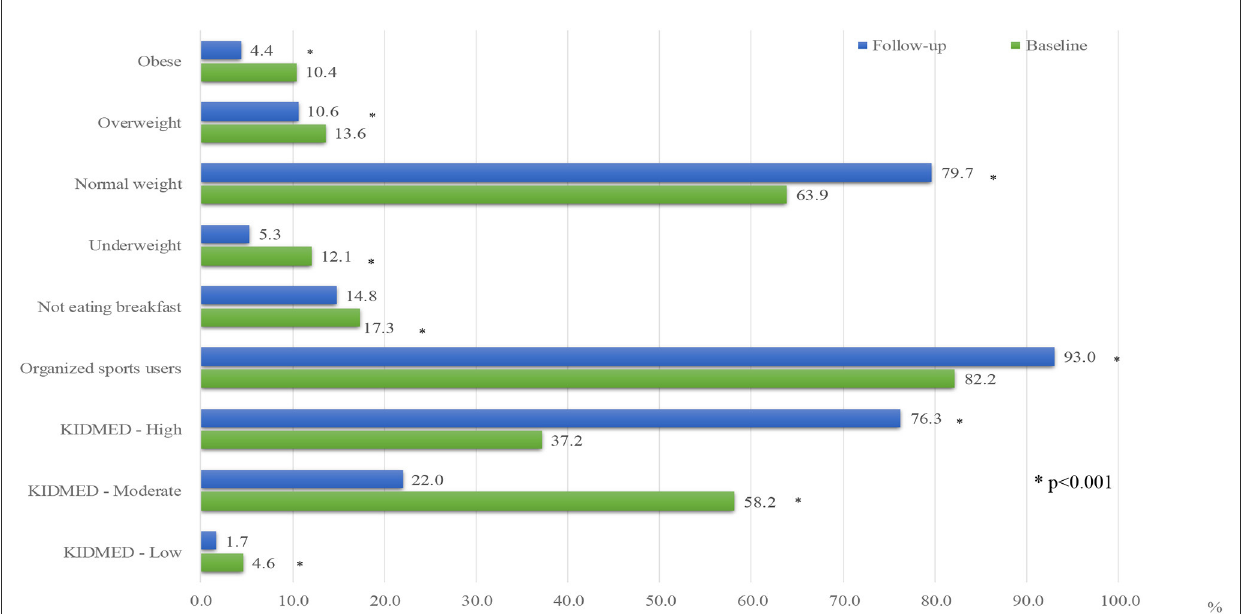
FIGURE1 Changes in nutrition status, active and sedentary lifestyle, and diet quality of monitored sub-group ( N = 701) within education-based intervention group ( N = 2,617) from the baseline to the 6–9-month